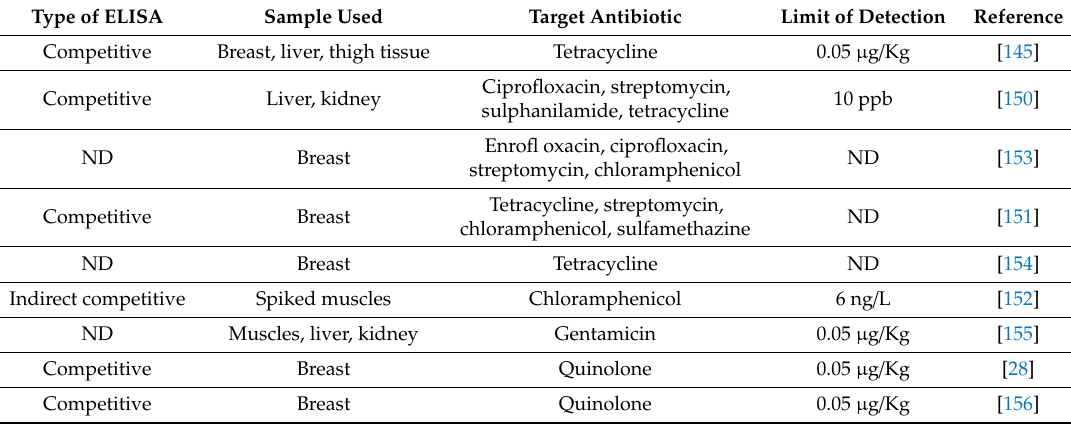
Table 10. ELISA-based approaches used for the detection of antibiotic residue in chicken